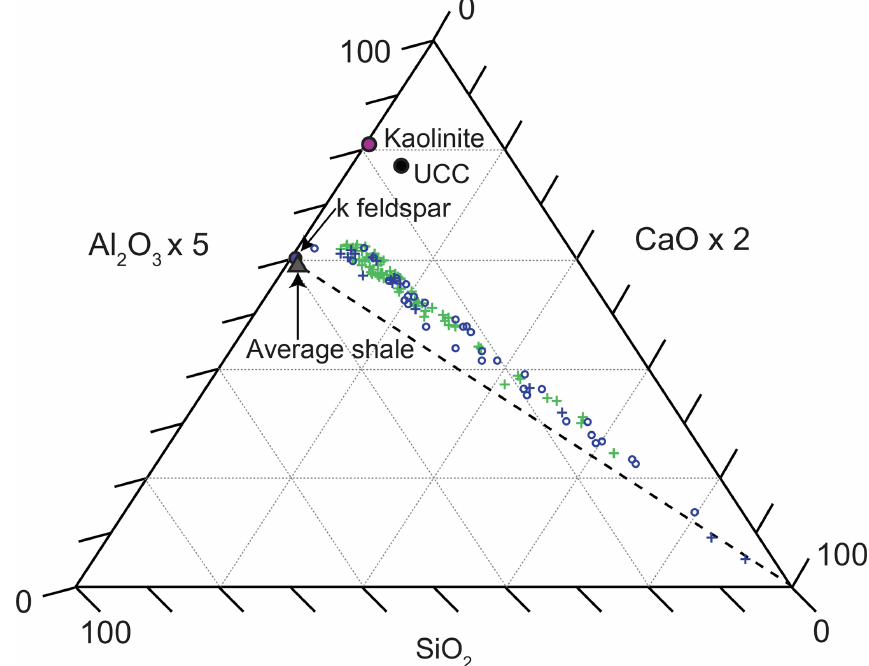
Figure 5. Ternary diagram (Brumsack, 1989) displaying the relative contributions of clay (Al 2 O 3 ), quartz (SiO 2 ), and carbonate (CaO) within all samples. Lower-variability mudstone interval (LVMI) samples are indicated by green crosses, and higher-variability mudstone interval (HVMI) samples are marked by blue symbols; TOC-rich samples (TOC > 10wt%) are indicated by blue circles, and TOC-lean samples (TOC < 10wt%) are indicated by blue crosses. Axes are scaled to improve the display of the data. Average shale (Wedepohl, 1991), upper continental crust (UCC; Rudnick and Gao, 2003), k feldspar, and kaolinite are plotted for reference. The dashed line shows the average shale–carbonate mixing